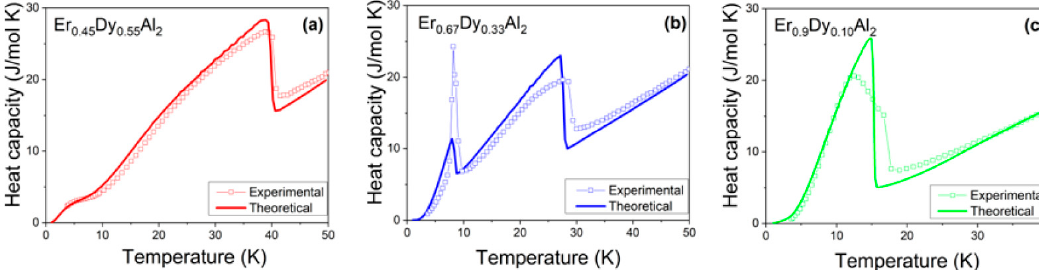
Figure 10. Heat capacity of the Er x Dy 1 − x Al 2 samples with x = 0.45 ( a ), x = 0.67 ( b ), and x = 0.90 ( c ). The symbols are the experimental measurements reported in [32] and the solid lines represent the theoretical results calculated using the model described above.